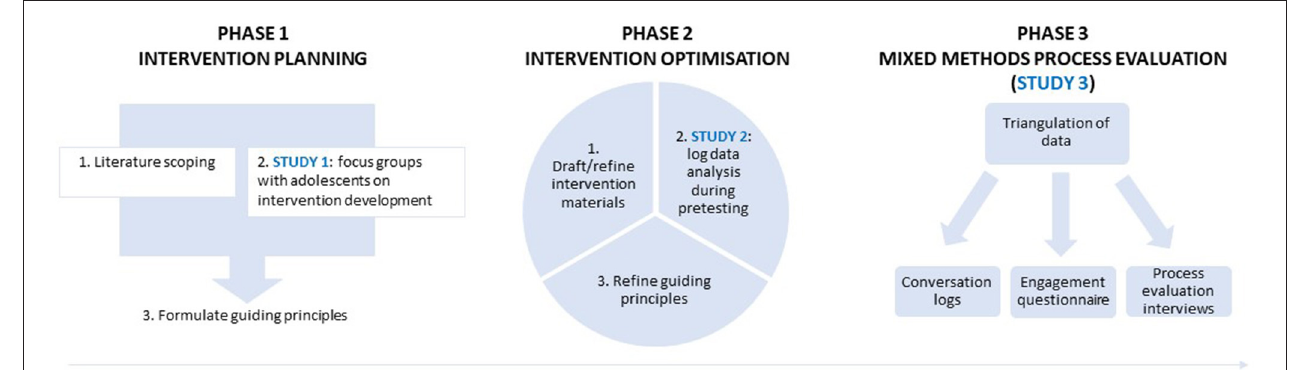
FIGURE 1 | Overview of the chatbot development phases, based on the PBA to intervention development (68,